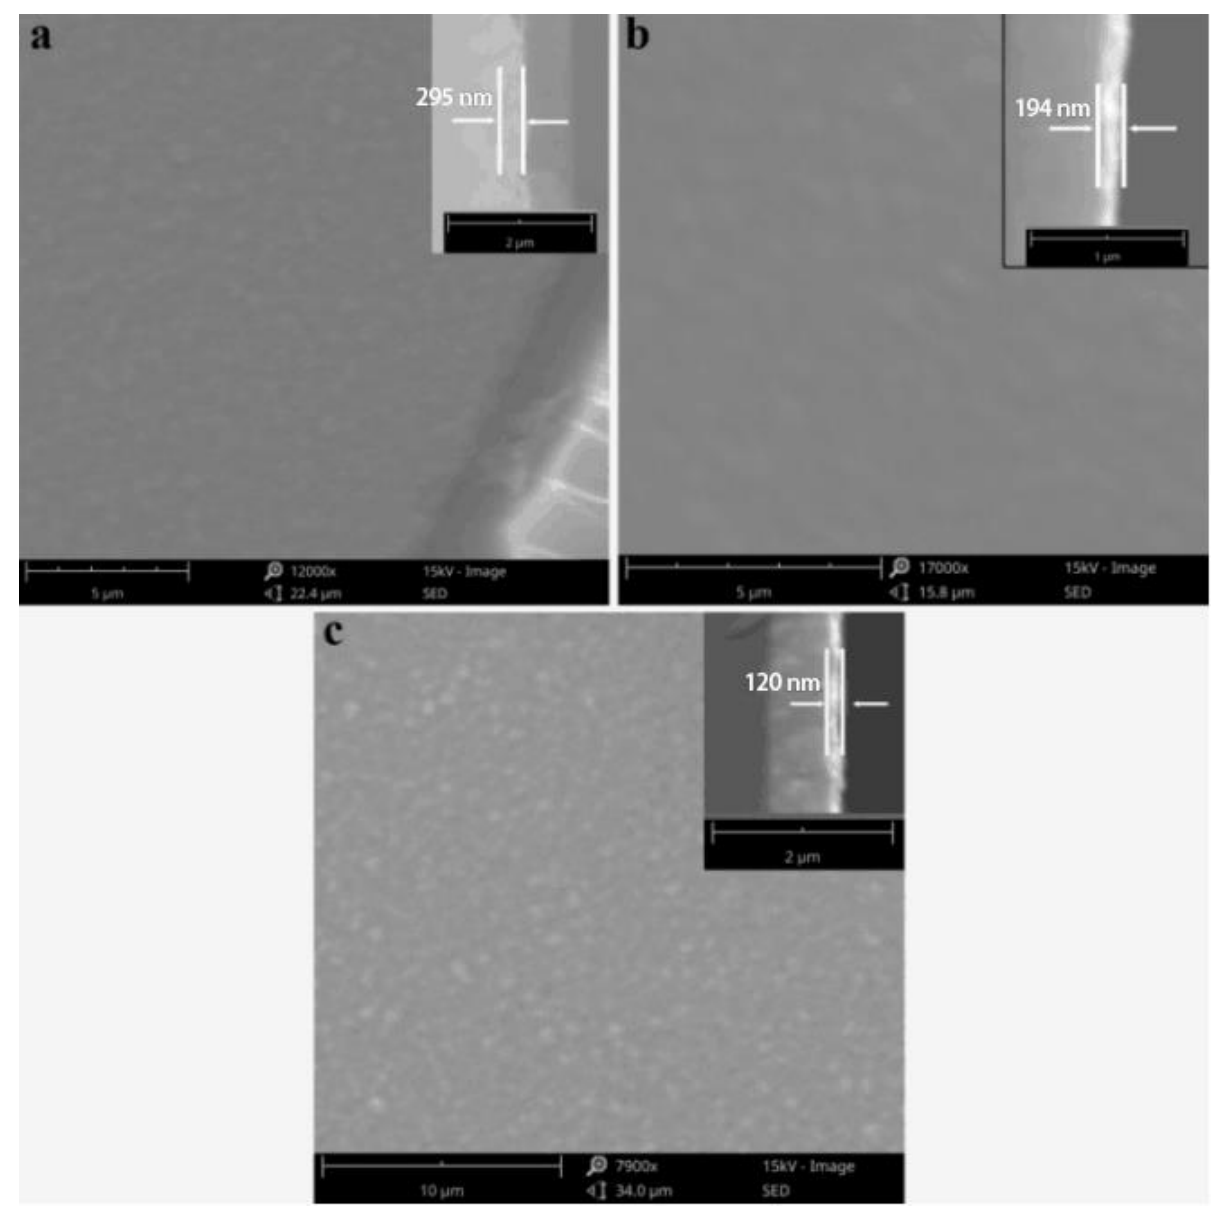
Figure 4. SEM images of front and cross-section of the TiO 2 layer at different spin-coating speeds: ( a ) 2000 RPM, ( b ) 3000 RPM, ( c ) 4000 rpm; The inset shows the section scan at the corresponding spin-coating speed.